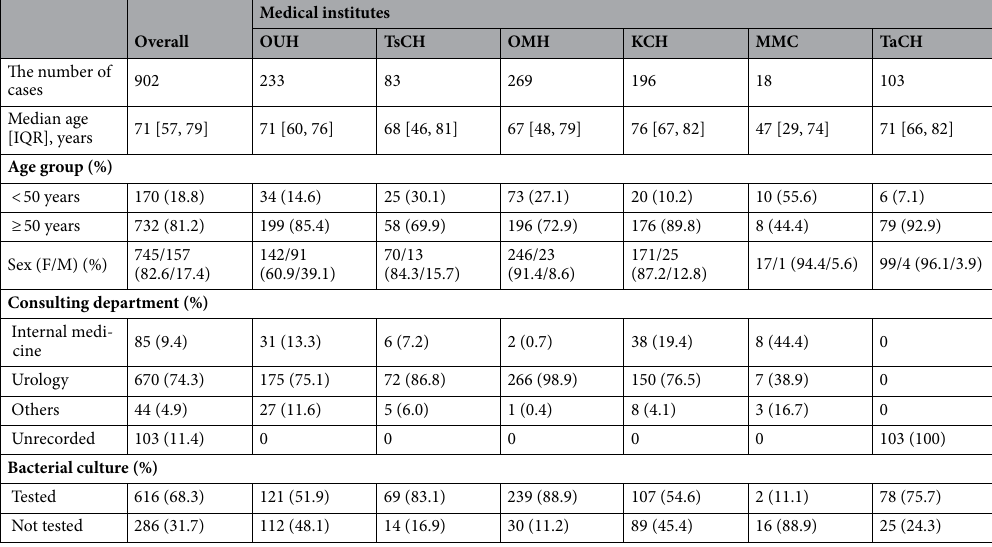
Table 1. The numbers and percentages of background data of the eligible cases in each medical institute. The International Classification of Diseases (ICD-10) codes were endorsed in May 1990 by the Forty-third World Health Assembly to develop the diagnostic classification standard for all clinical and research purposes. IQR interquartile range, ND no data.